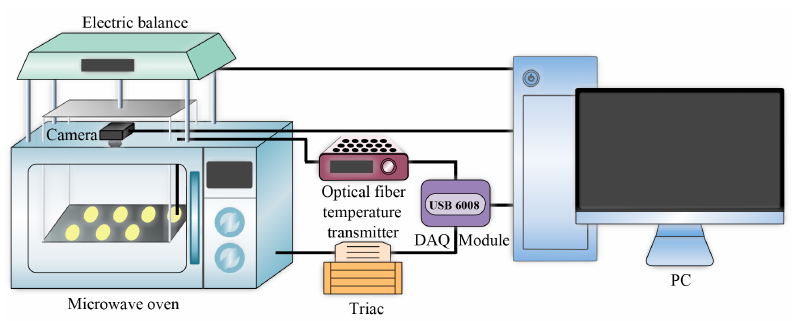
Figure 1. The schematic of the experimental